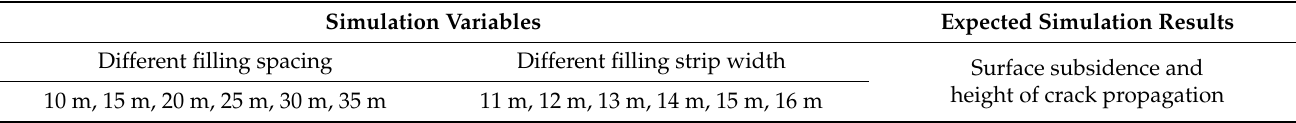
Table 3. Simulation